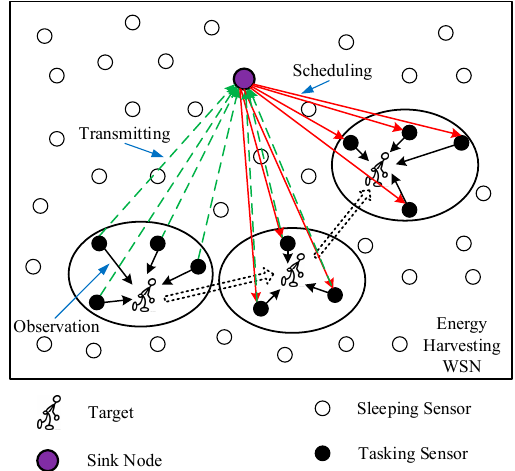
Figure 1. The target tracking system in an energy-harvesting wireless sensor network (WSN).